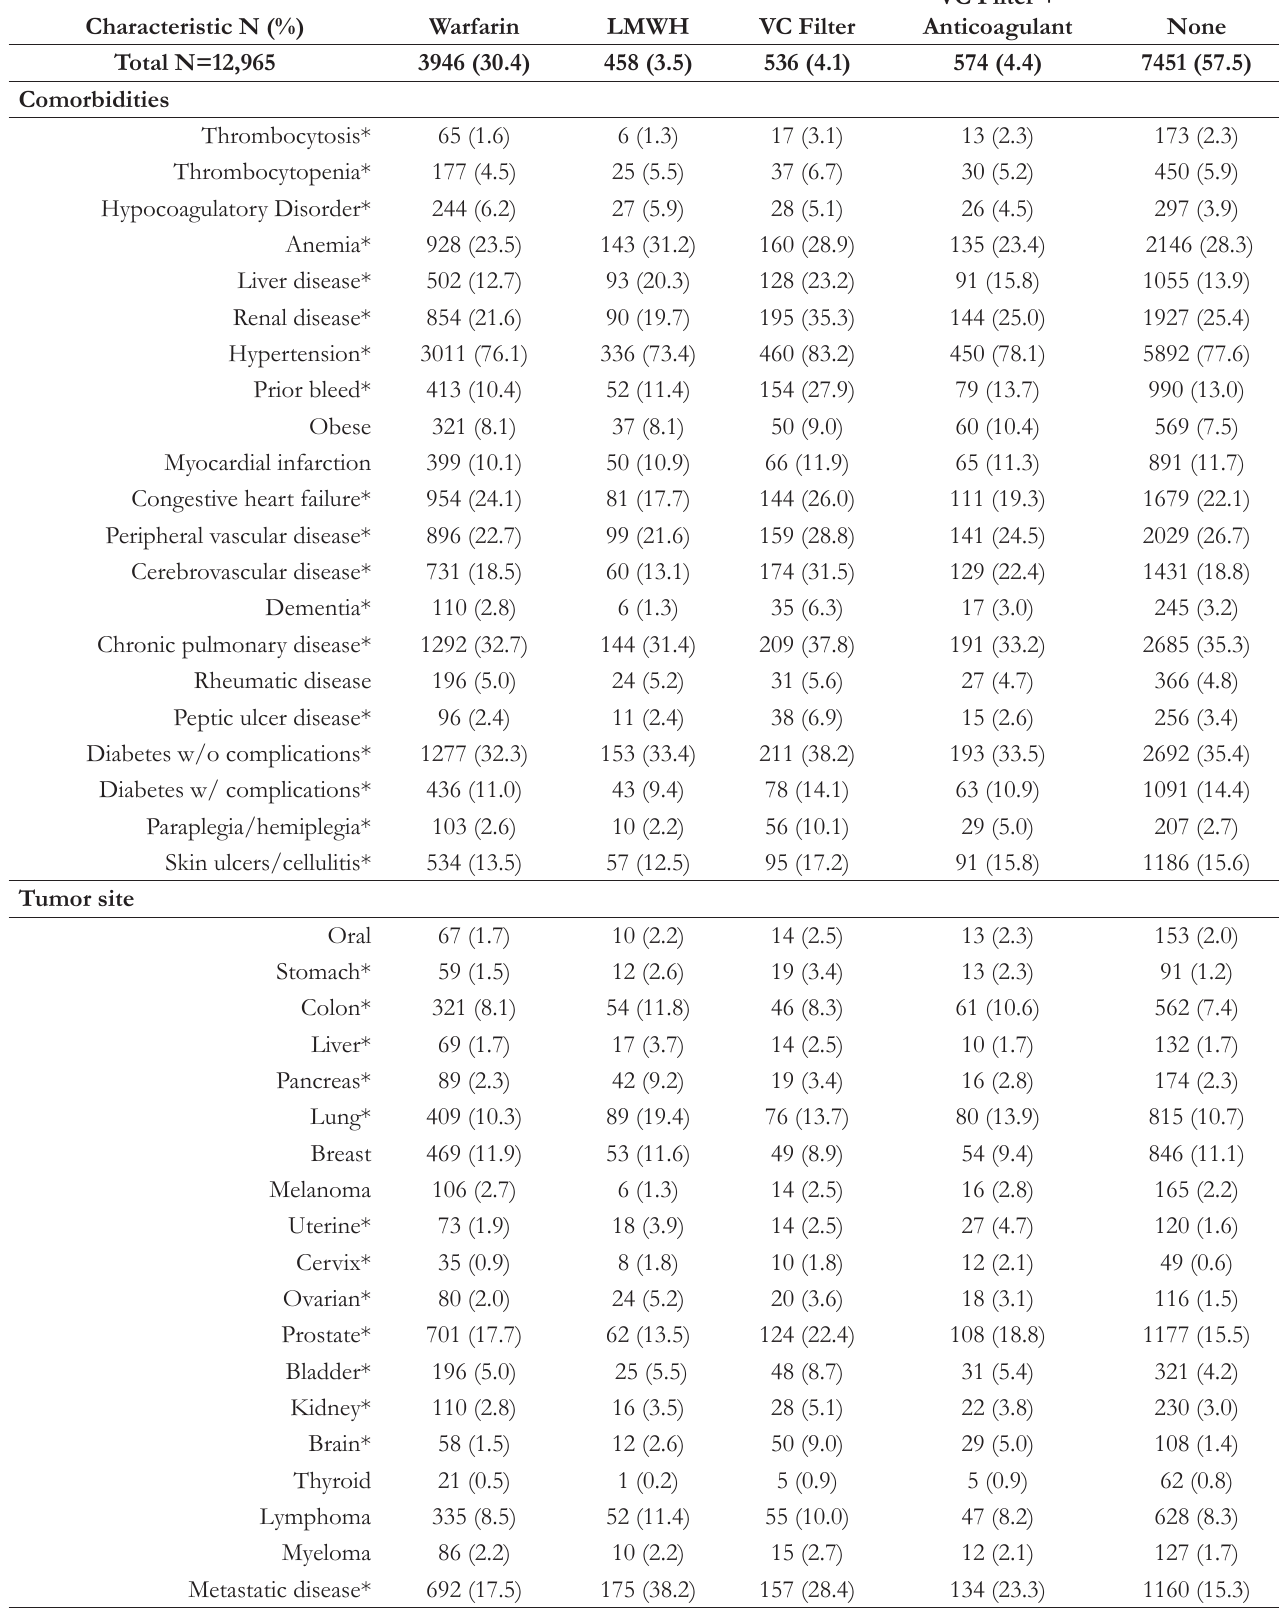
Table 1. Baseline Demographic and Clinical Characteristics by Treatment Group - cont’d Characteristic N